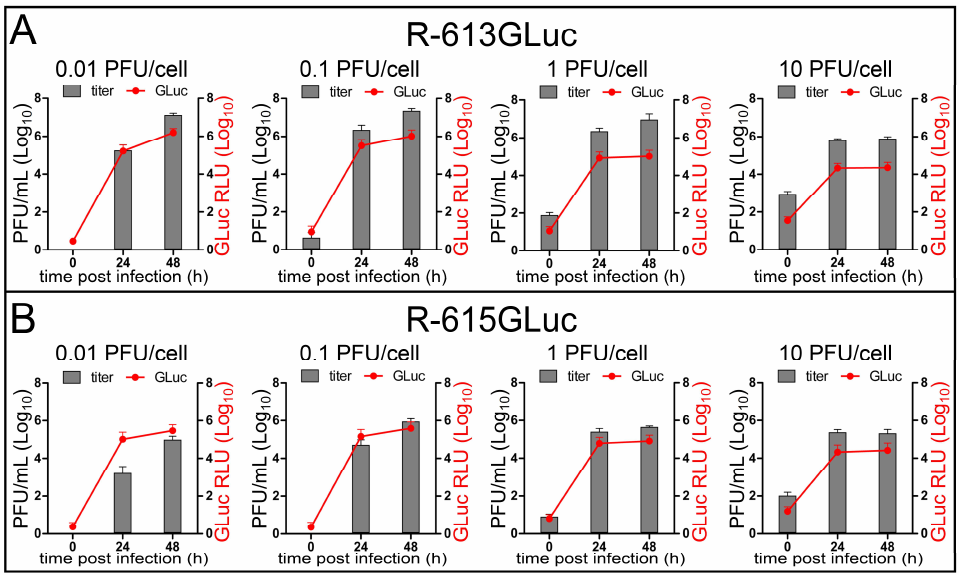
Figure 9. Secretion of GLuc parallels virus replication. Expression of Gaussia Luciferase in U251-EGFRvIII cells infected with R-613GLuc ( A ) or R-615GLuc ( B ) at MOI ranging from 0.01 to 10 PFU/cell. Gaussia Luciferase activity was read from an aliquot of supernatant medium taken from infected cell cultures at the indicated time points, before freezing the samples for total (extra + intra-cellular) virus titer determination. Gaussia Luciferase activity is plotted after normalization to the background of the viral inoculum. Points and bars represent the average of three independent experiments ± SD.